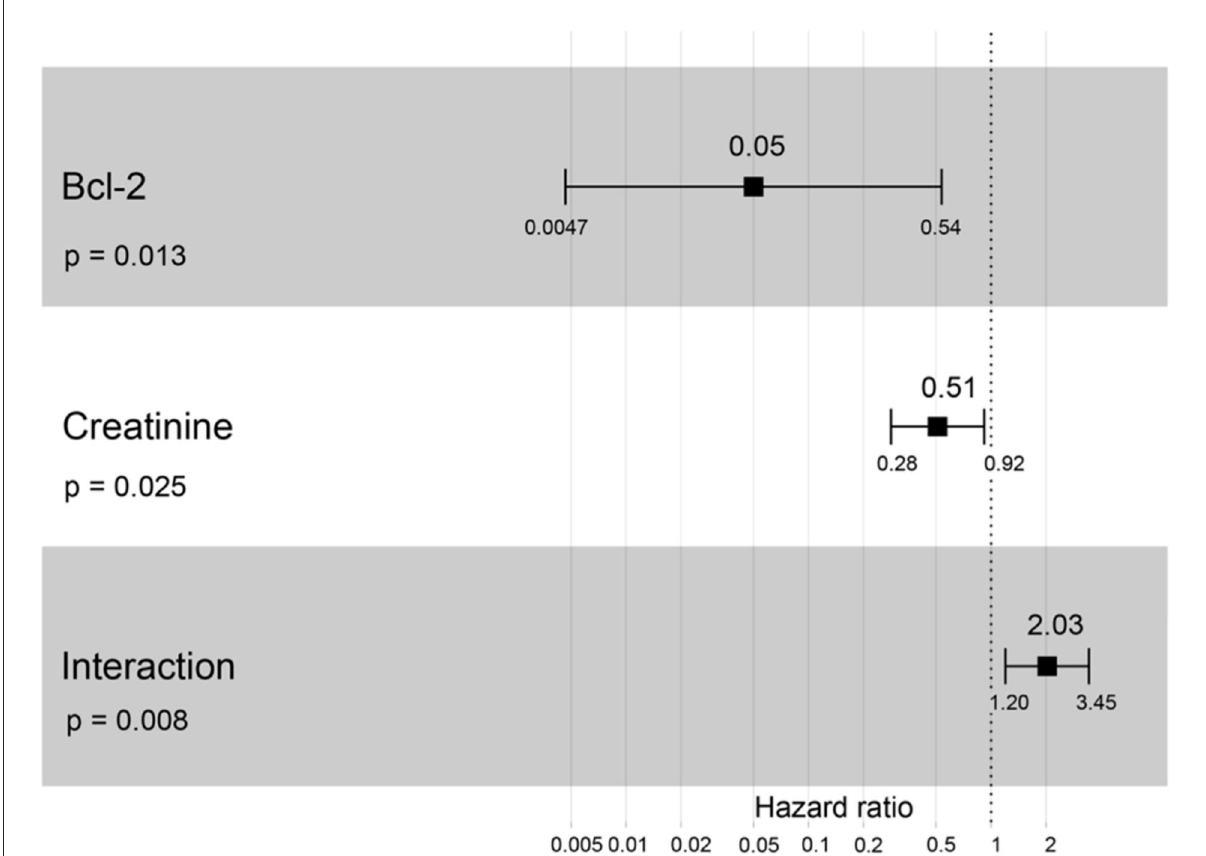
FIGURE10 Forest plot output for the interaction of Bcl-2 with creatinine that is covariate with the CKD progression based on hazard ratios (HRs) via Cox regression analysis. Squares represent hazard ratios. Bars represent 95% confidence